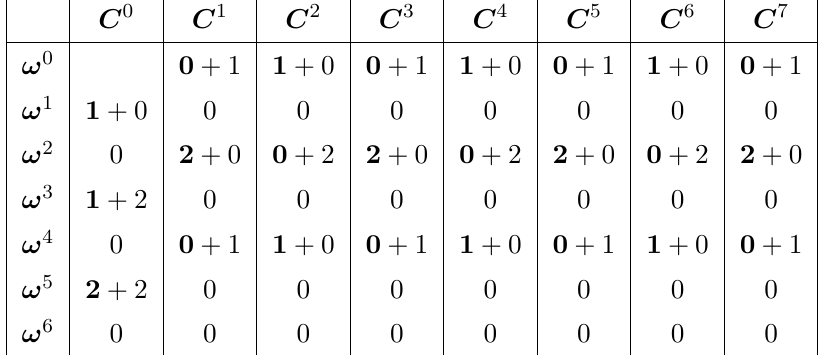
Table 3 . On-shell closed/gauge-invariant currents in 4 d Higher Spin Gravity to the lowest order. The sum in each cell gives the number of independent currents that are of ω m C n -type, i.e., involve m one-forms ω and n zero-forms C , cf. table 6. The (first) boldface number is the number of currents that do not vanish upon projection to the physical